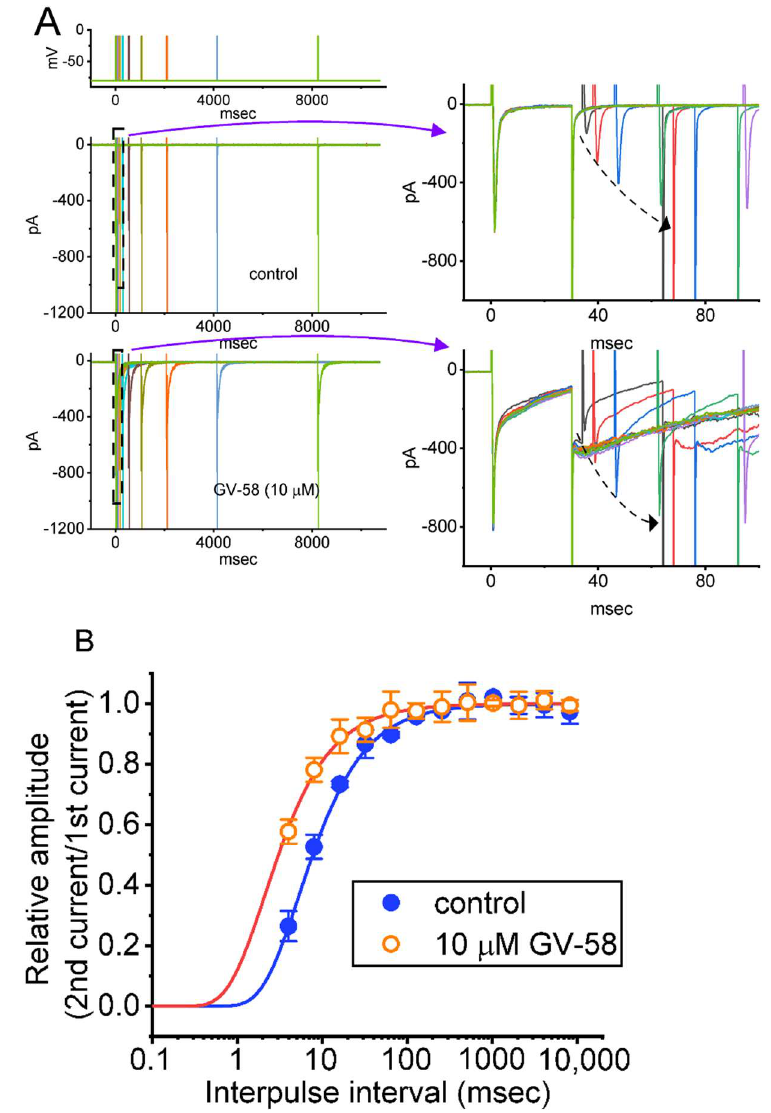
Figure 4. Effect of GV − 58 on the recovery of I Na inactivation identified in GH 3 cells. In this set of experiments, as whole − cell configuration was securely established, we applied two − step voltage protocol in a geometrics progression as indicated in the uppermost part of ( A ). ( A ) Representative current traces obtained in the absence (upper) and presence of 10 µ M GV − 58. The panels on the right side, included to show better illustrations, indicate the expanded records from dashed boxes on the left side. The dashed arrow indicates an incremental progression in the trajectory of current inactivation with the increasing interpulse interval. ( B ) The relationship of interpulse interval versus the relative amplitude taken in the absence (filled blue circles) and presence (open red circles) of 10 µ M GV-58 (mean ± SEM; n = 8 for each point). The relative amplitude in the y -axis was obtained by dividing the second amplitude activated by 30 ms depolarizing command voltage from − 80 to − 10 mV by the first one. Of note, the x-axis is illustrated in a logarithmic scale. The smooth curve in the absence and presence of 10 µ M GV − 58 was fitted to a single-exponential function with time constants of 5.34 and 2.11 ms, respectively. The presence of GV − 58 was noted to result in an evident increase in current recovery (i.e., a reduction of recovery time constant).